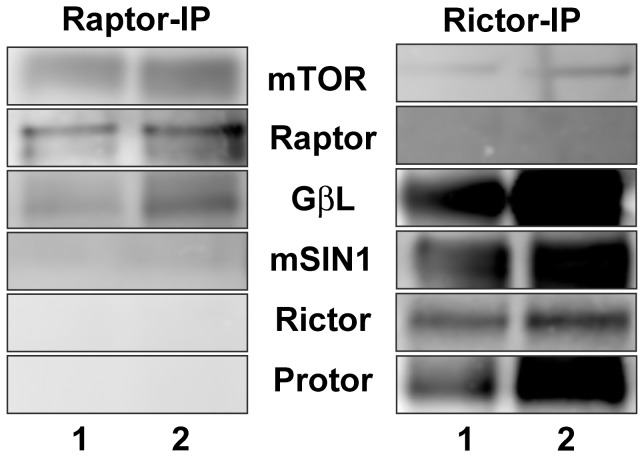
Characterization of protein constituents of Raptor and Rictor immunoprecipitates of 1-LN cells treated with α2M*.A representative immunoblot from three to four experiments of mTOR, Raptor, GβL, mSIN1, Rictor and Protor presence in these respective immunoprecipitates is shown. The cells were treated with: (1) buffer and (2) 50 pM of α2M* for 25 min.